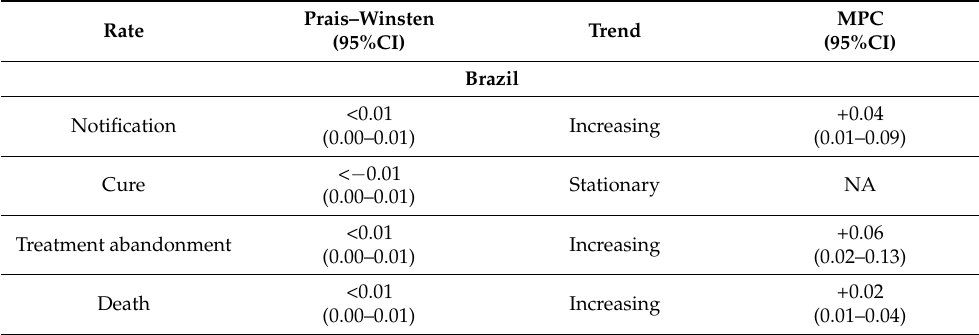
Table 1. Classification of the temporal trend of tuberculosis and its outcomes in Brazil and its macro- regions, according to the Prais-Winsten autoregression technique, in the pre-COVID-19 pandemic period